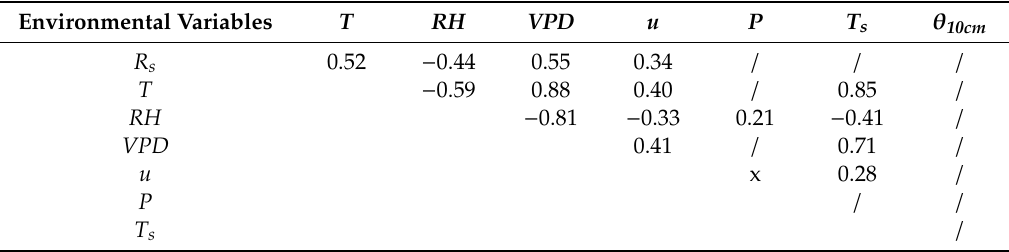
Table 1. Correlations among the 30-min averages of environmental variables during the examined period. Coe ffi cients below absolute value of 0.2 are marked with / . θ 10cm represents soil moisture at surface layer (0 − 10 cm).